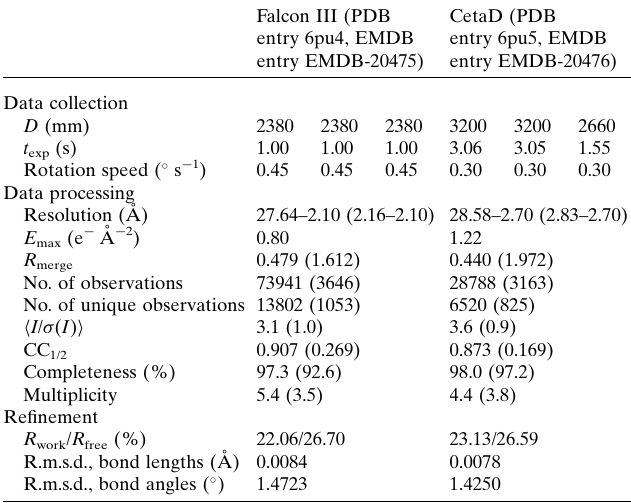
Table 1 Processing and refinement statistics for proteinase K recorded on the Falcon III and CetaD